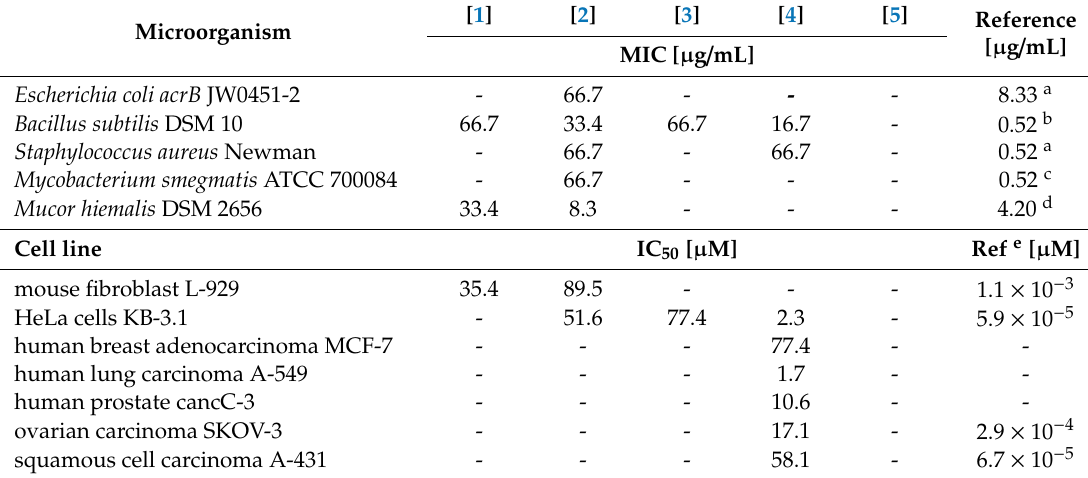
Table 2. Antimicrobial and cytotoxicity activities of 1 – 5